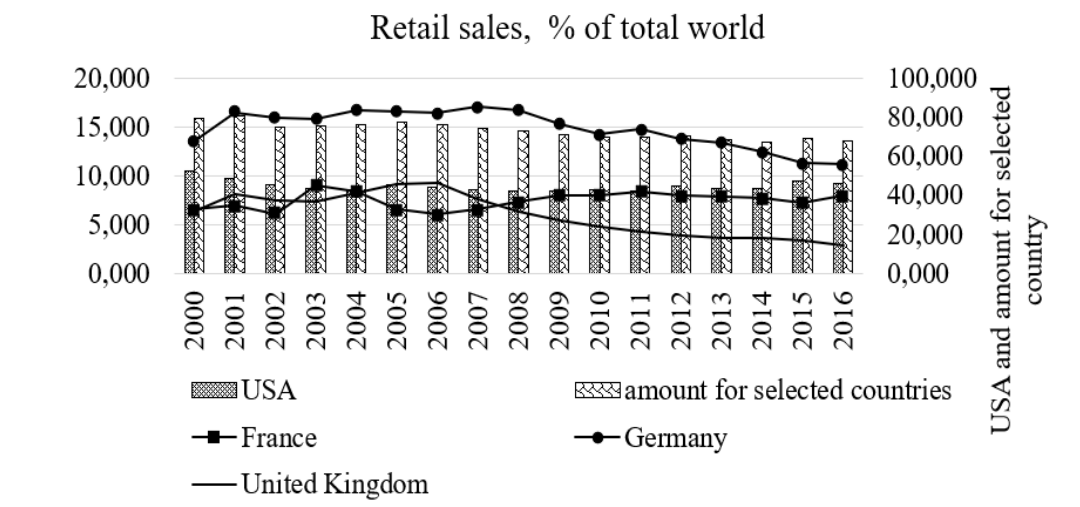
Fig. 2. Specific weight of the market of separate countries in the world organic products